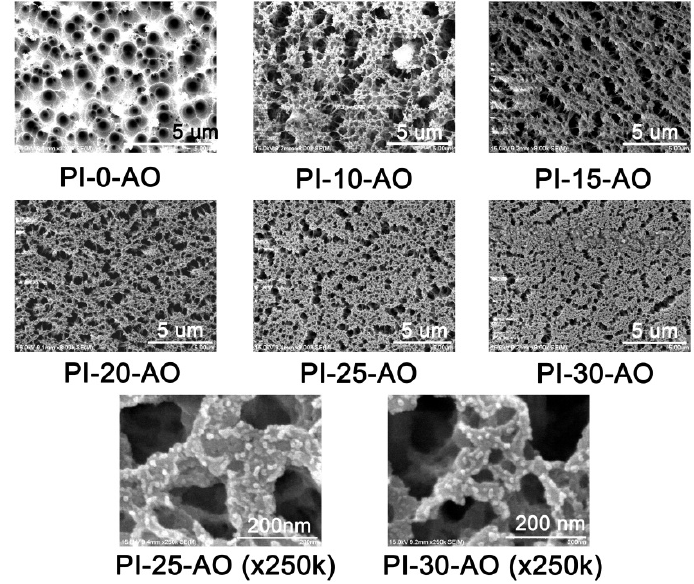
Figure 12. SEM micrographs of POSS ‐ PI films after AO erosion (AO fluence: 2.16 × 10 21 atoms/cm 2 ).